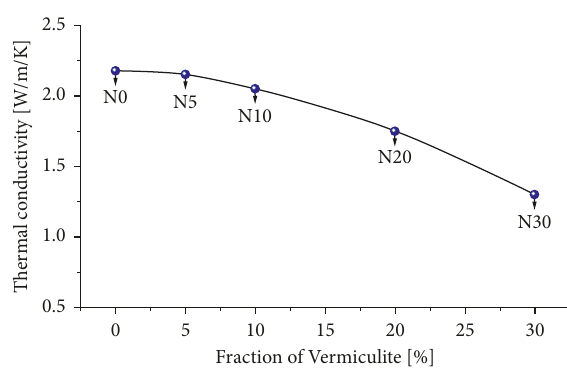
Figure 5: Thermal conductivity of normal concrete. On increasing the fraction of vermiculite, k